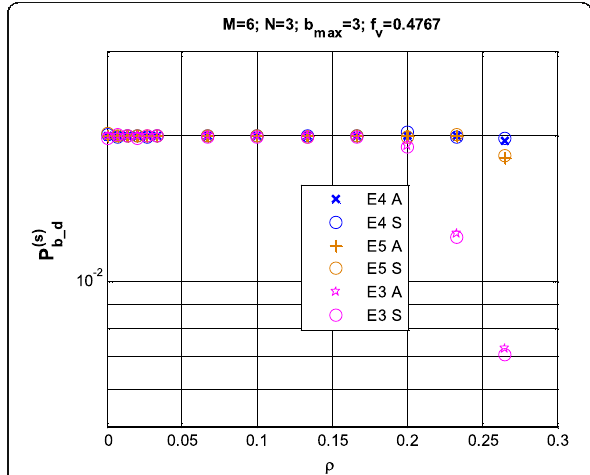
Fig. 10 New call blocking probability of secondary data users for the corresponding optimal configuration of each strategy as function of the primary channel utilization factor